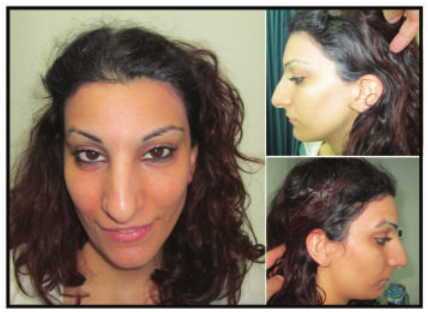
Figure 1: Frontal and profile views of our patient.